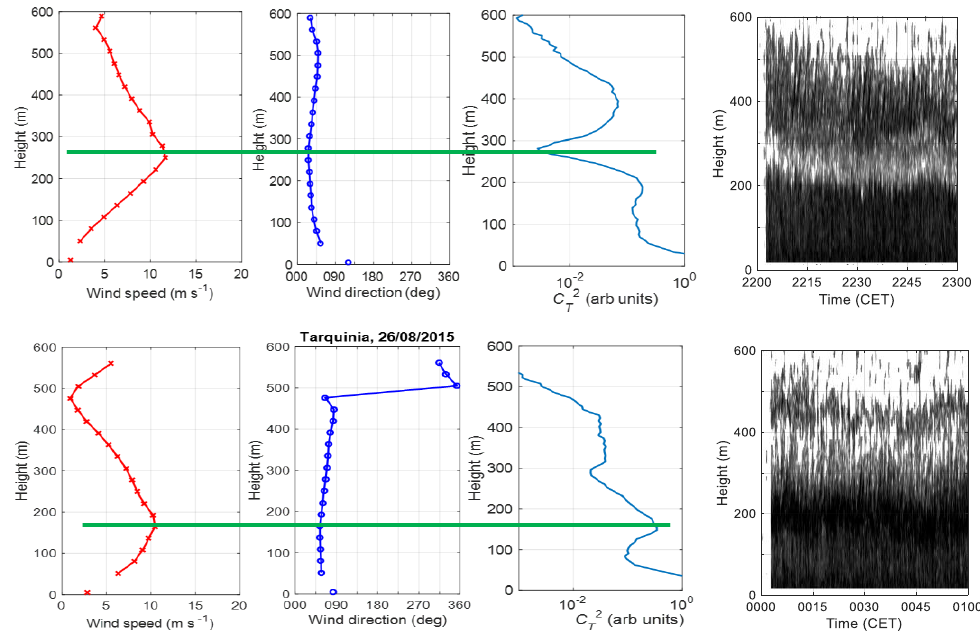
Figure 23. Examples of two types of turbulence distribution near the LLJ core. Sodar echograms with superimposed wind speed (red lines) and direction (blue lines) profiles, as well as C T 2 profiles. Upper panels, 12 August 2015; lower panels, 26 August 2015.